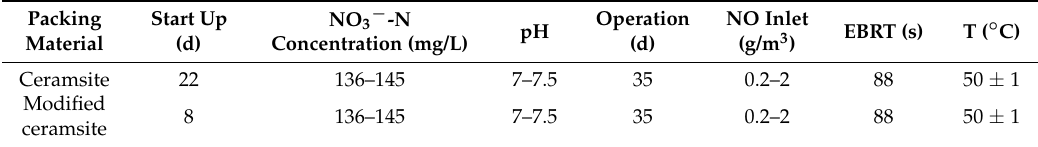
Table 1. The operating conditions for each packing